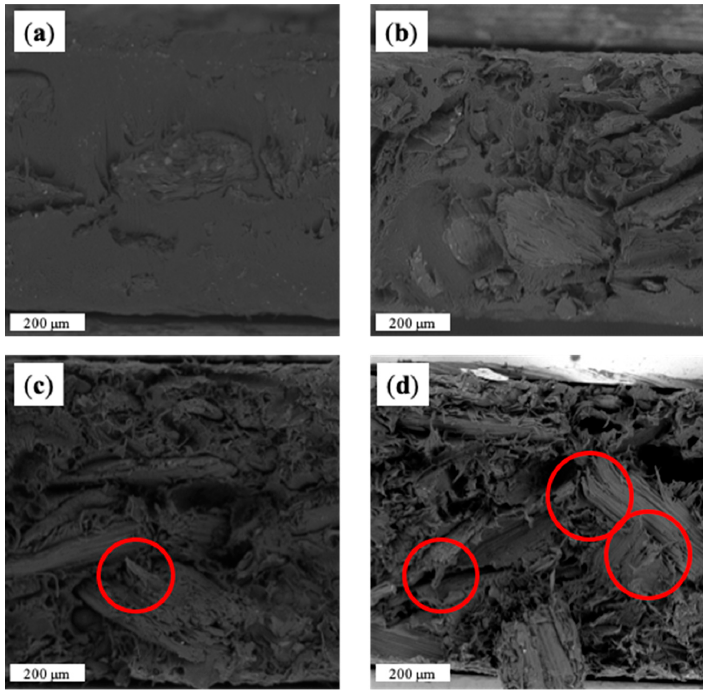
6 of 10 Figure 3. Optical image ( a ) and SEM micrograph ( b ) of HC powder. Morphological analysis was also performed on the transverse fracture surfaces of CM samples, for which relevant SEM micrographs are reported. In Figure 4, it is possible to notice an almost homogeneous dispersion of the filler in each CM sample. In addition,